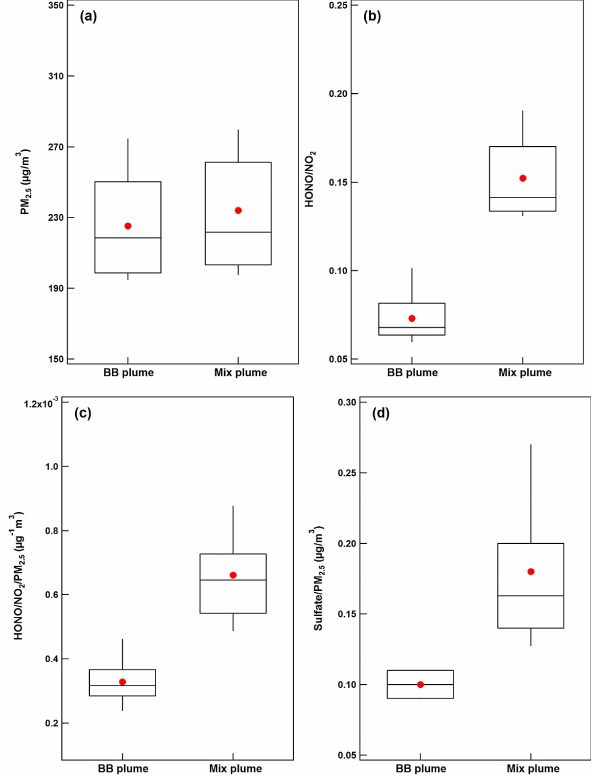
Figure 11. Whisker plots of (a) PM 2 . 5 mass, (b) ratios of HONO to NO 2 , (c) ratios of HONO / NO 2 to PM 2 . 5 mass, (d) ratios of sulfate to PM 2 . 5 , in the selected PM 2 . 5 mass concentration range (190– 300µgm − 3 ) in the BB plume (10 samples) and the mixed plume (27